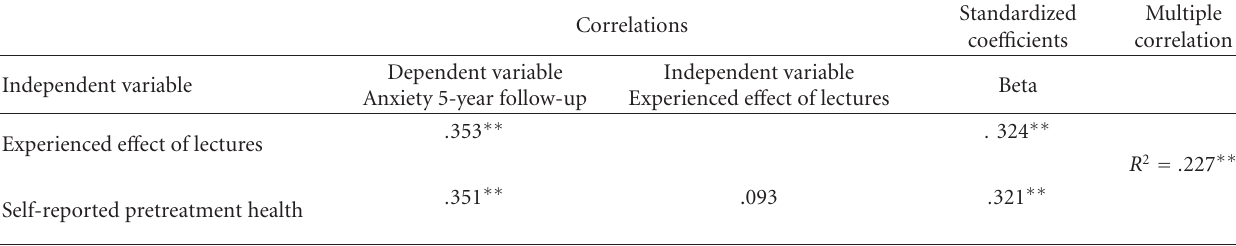
Table 4: Results of simultaneous multiple regression of the variation in anxiety after 5-year follow-up ( n = 65).